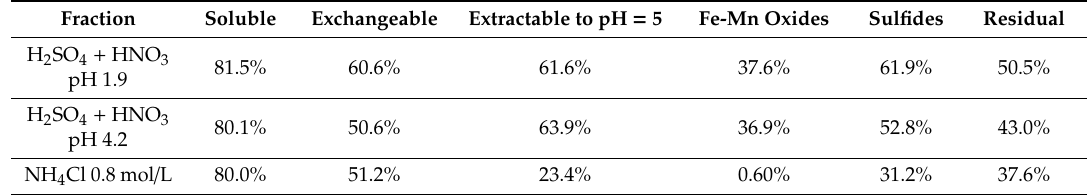
Table 5. Copper removal e ffi ciency for each fraction. Sample analyzed by the seven-fraction procedure. Fraction Soluble Exchangeable H 2 SO 4 + HNO 3 pH 1.9 H 2 SO 4 + HNO 3 pH